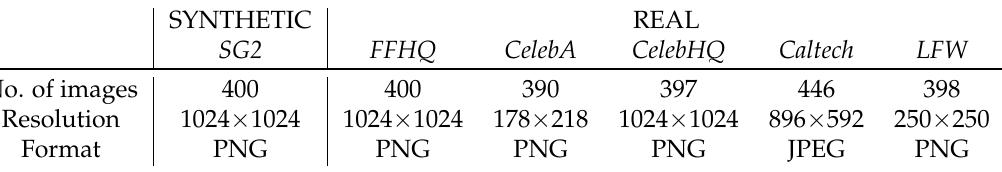
Figure 6. Summary of the face image data used in the